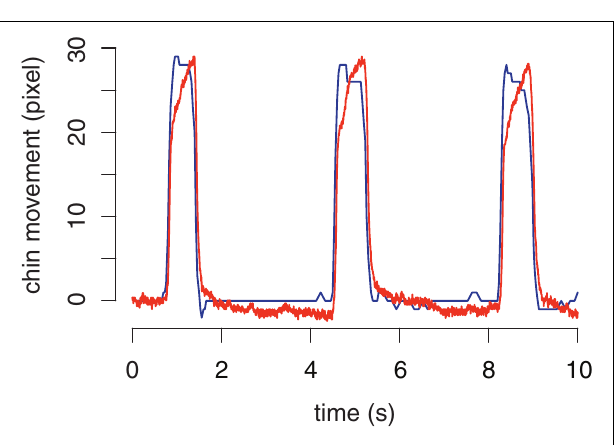
FIGURE 6 | Comparison of a video recording and a concurrent bend sensor recording of mouth opening. The blue curve represents the opening and closing of the mouth, determined with an fMRI-safe video camera. The red curve represents the bend sensor signal in arbitrary